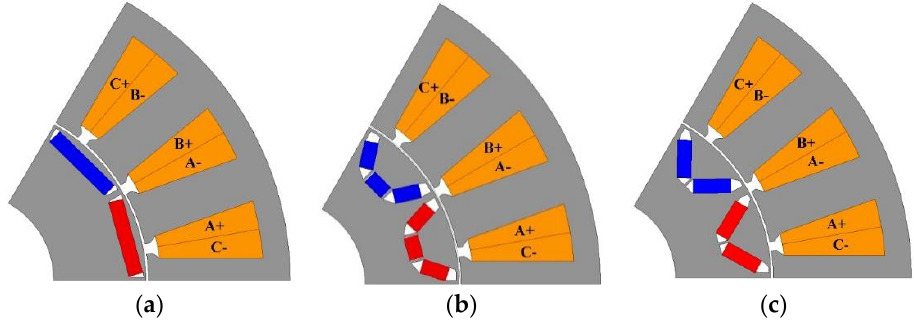
Figure 2. A 1/6 periodic model of a 15 kW HEV motor. ( a ) Bar-type interior permanent magnet synchronous motor (IPMSM); ( b ) U-type IPMSM; ( c ) V-type IPMSM. Table 1. Specification of electric motors.